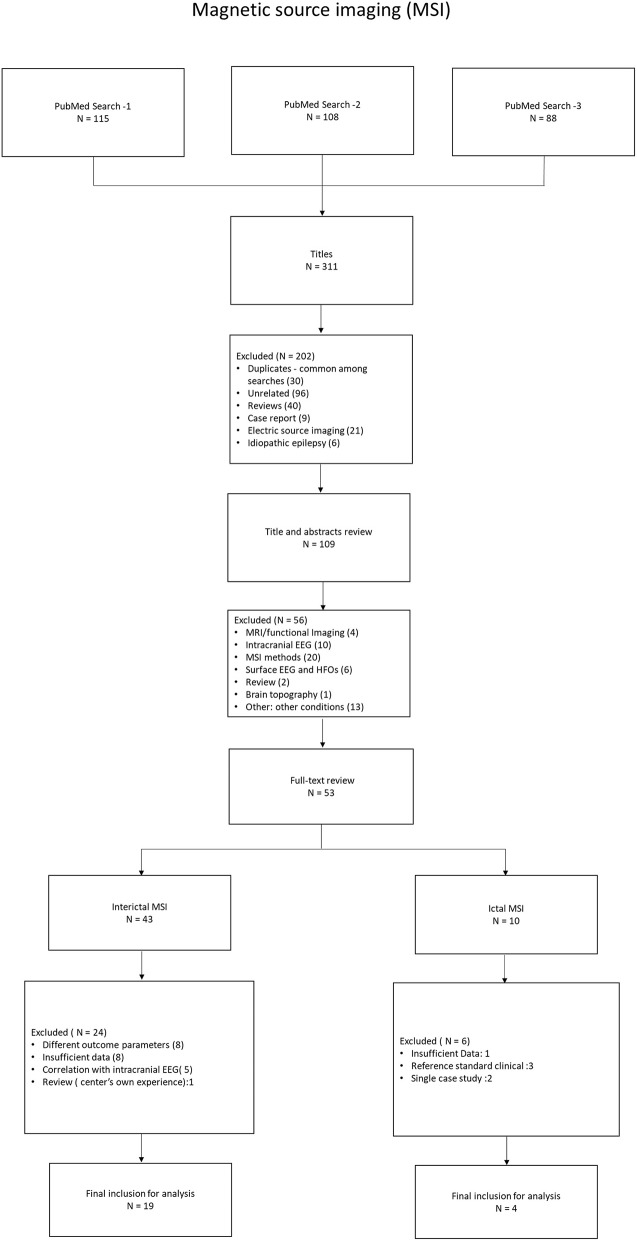
Flow diagram of the studies on MSI, retrieved for the review.